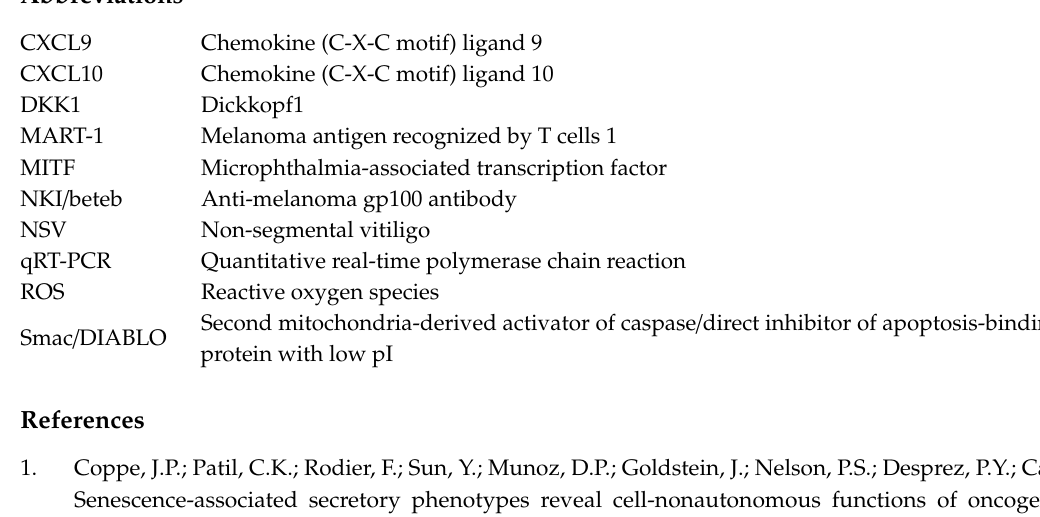
Figure S1: Number of total melanocytes on the basement membrane in the perilesional epidermis of NSV patients and in normal control skin samples, Table S1: The raw data of 33 patients with normal skin, Table S2: The raw data of 54 patients with